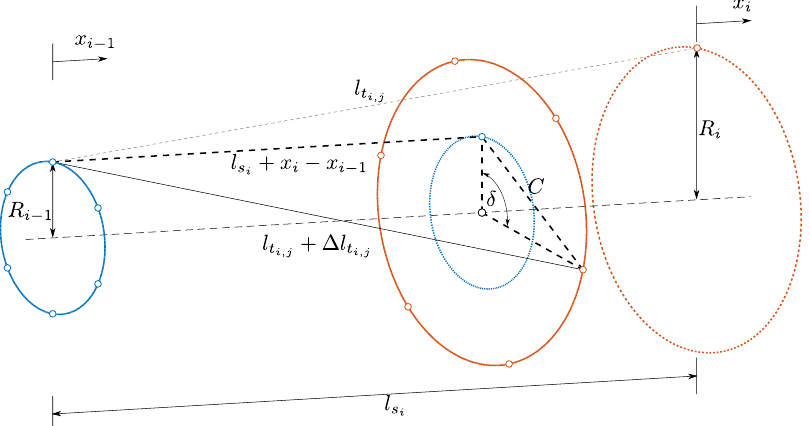
, of the j -th tether within the i -th TRPT section. i , j